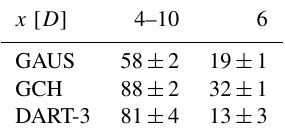
Table 5. Model run time [ms] when simulating seven (4D ≤ x ≤ 10D) and one ( x = 6D) downstream distances expressed as mean ± standard deviation over 40